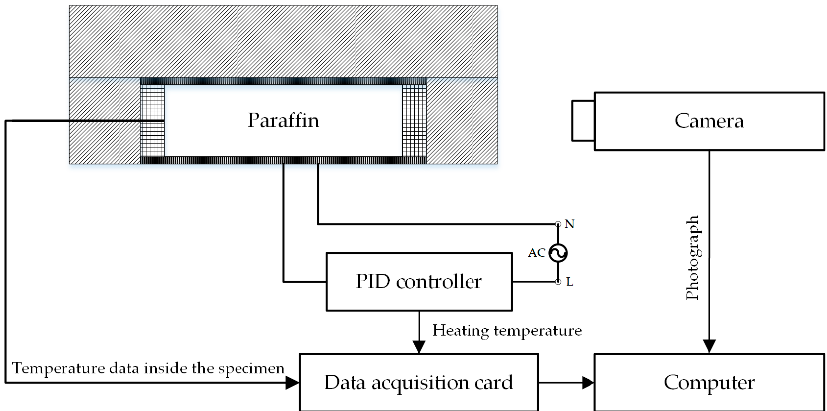
Figure 3. The schematic of the experimental apparatus.